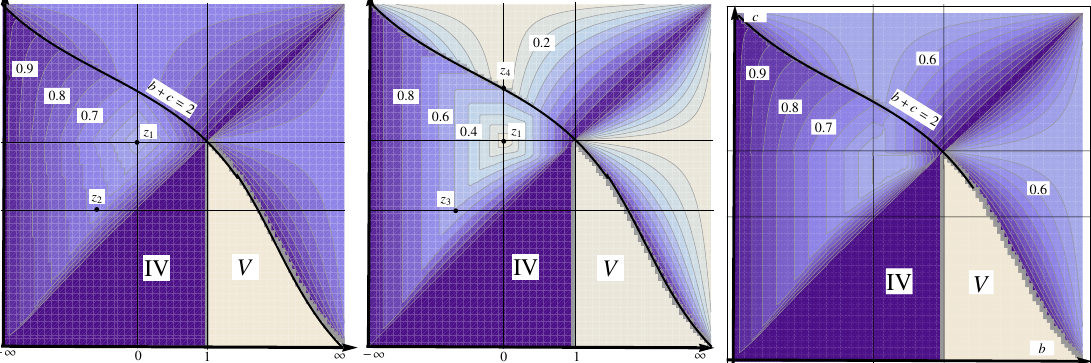
Figure 4. Values of δ F with pure, correlated and mixed strategies. The darker shade means that the value of δ F is